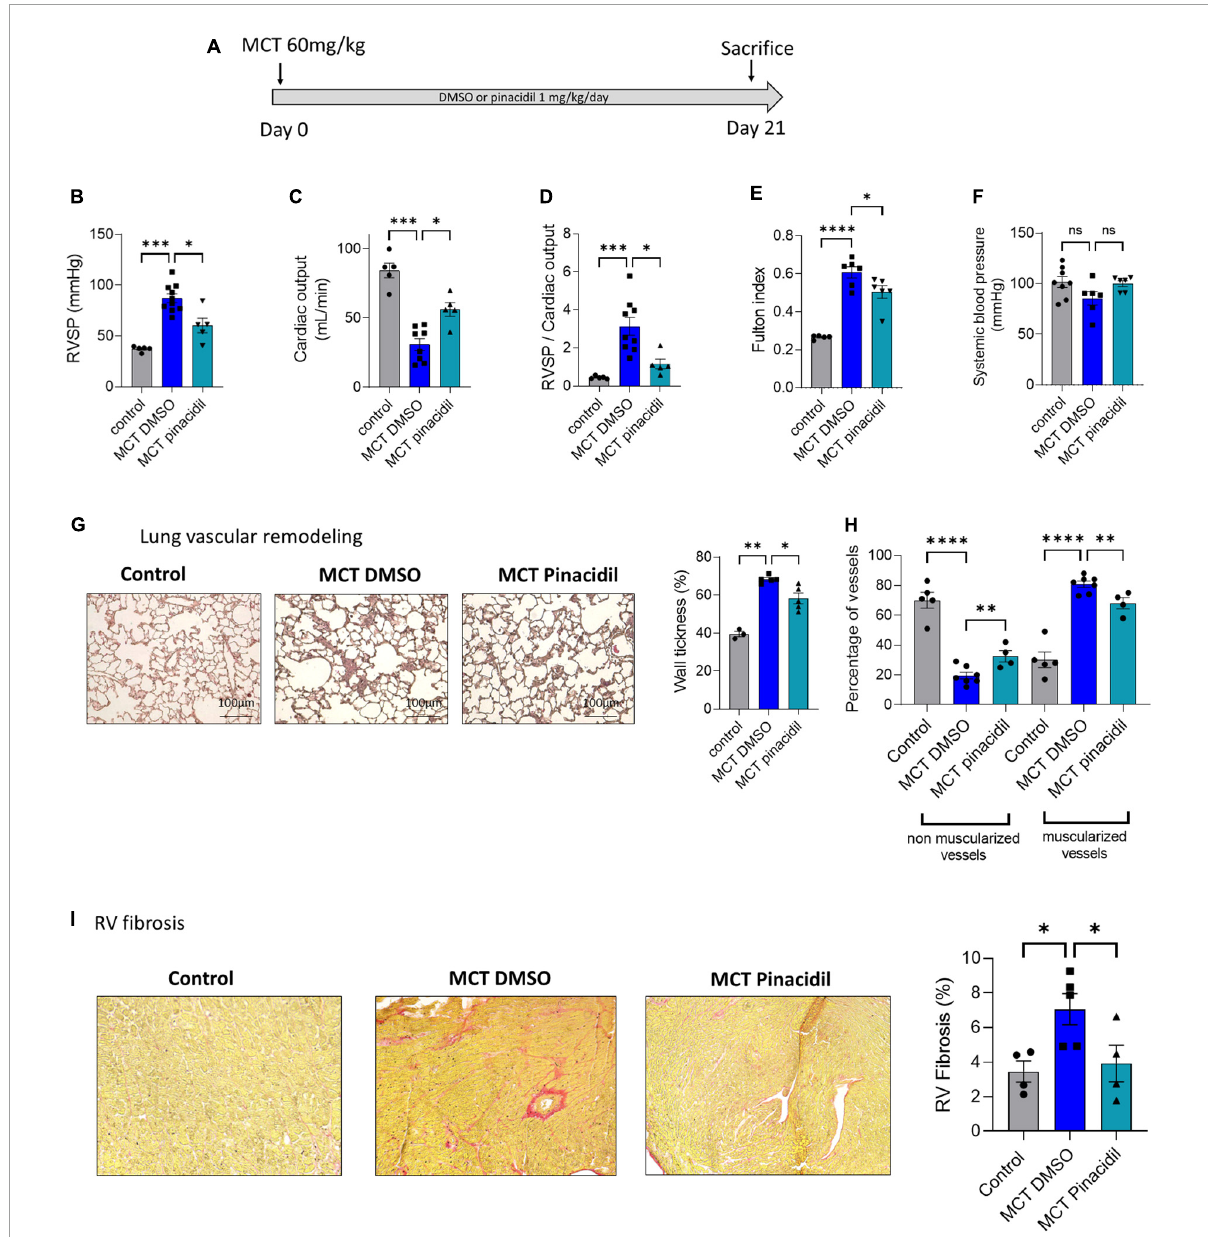
FIGURE6 In vivo long-term pinacidil treatment interferes with MCT-PH development. (A) In vivo experimental design. Pinacidil (1 mg/kg/day for 3 weeks) was administered long-term during MCT exposure by intraperitoneal injection. (B) RVSP (mm Hg; n = 5–10 different rats per condition) (C) , Cardiac output (CO; ml/min) ( n = 5–8 different rats per condition). (D) PVR (evaluated by the RVSP/CO ratio) ( n = 5–8 different rats per condition). (E) Fulton index (RV/LV + septum) ( n = 6 different rats per condition). (F) Pulmonary vessel occlusion (%) was analyzed by HES ( n = 3–5 rats per condition). (G) Percentage of non-muscularised and muscularised vessels [100 vessels per rat, ( n = 4–7 rats)] as measured by immunostaining against α -smooth muscle actin ( α SMA) and Von Willebrand Factor (VWF). (H) Interstitial fibrosis was analyzed with Sirius red staining in the RV compartment from control, MCT + DMSO, and MCT + pinacidil rats. (I) Quantification of the percentage of fibrosis in RV tissue in each condition ( n = 20 images per rat from 4–5 different rats). ns: non-significant, ∗ P < 0.05, ∗∗ P < 0.01, ∗∗∗ P < 0.001, ∗∗∗∗ P < 0.0001.